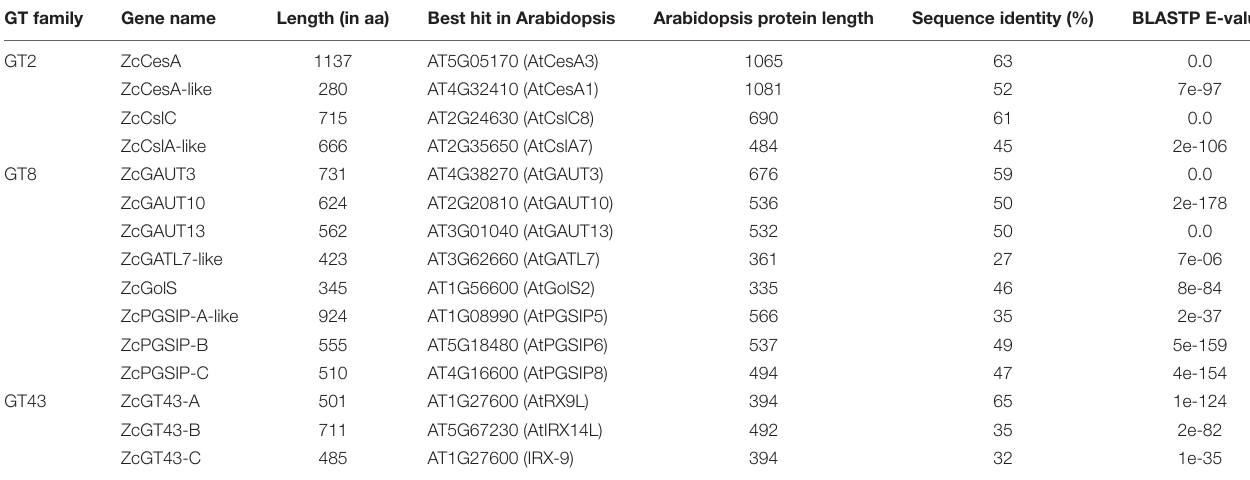
TABLE 5 | Selected GT enzyme encoding genes from UTEX 1559 and their best Arabidopsis homologs. GT